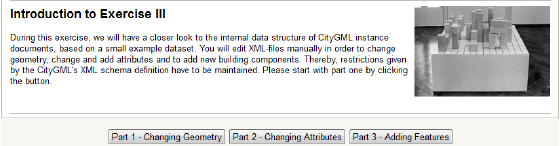
Figure 5: Introduction to exercise III with links to the subtasks 1-3